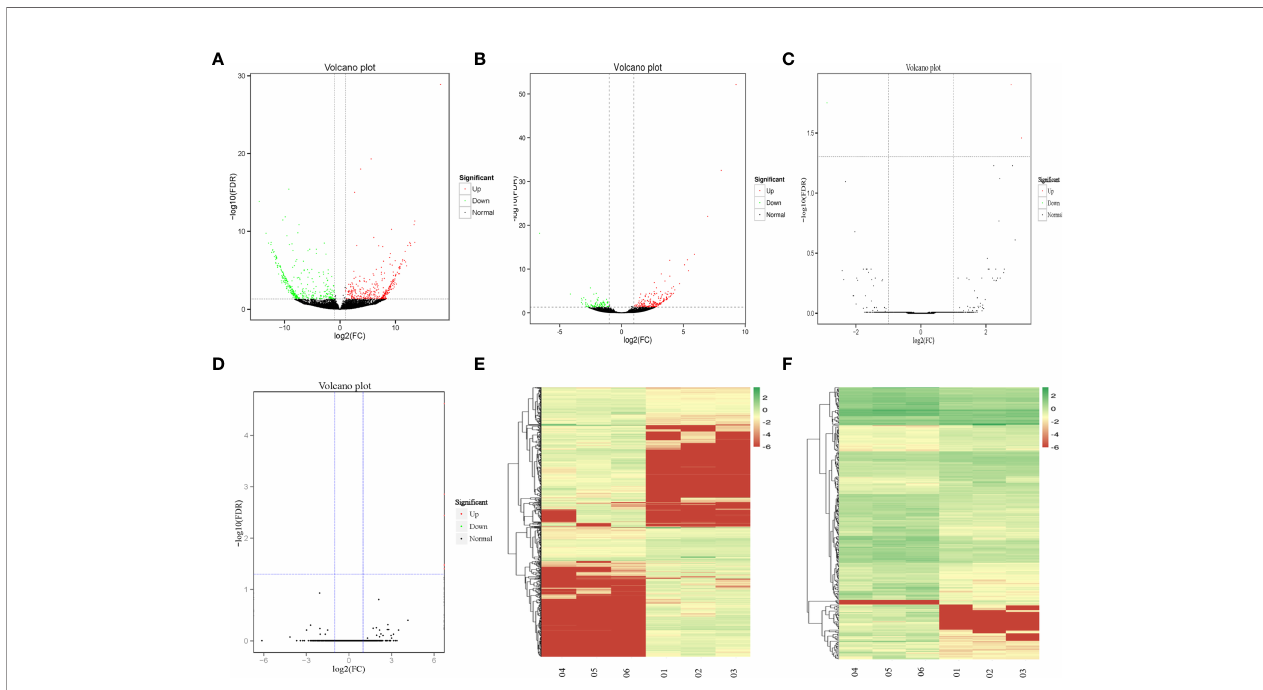
FIGURE 1 | The DEGs between recurrent and primary GBM. (A – D) Volcano map of DElncRNAs, DEmRNAs, DEcircRNAs, and DEmiRNAs, expression pro fi les between recurrent and primary GBMs. The x-axis represents an adjusted a log2FC and the y-axis represents the P-value. The green dots represent down-regulated DEGs, the red dots represent up-regulated DEGs, and the black dots represent non-differentially expressed RNAs. (E, F) Unsupervised clustering analysis showing expression pro fi les of lncRNAs and mRNAs between recurrent and primary GBMs. The color gradient from green to red shows a trend from low expression to high